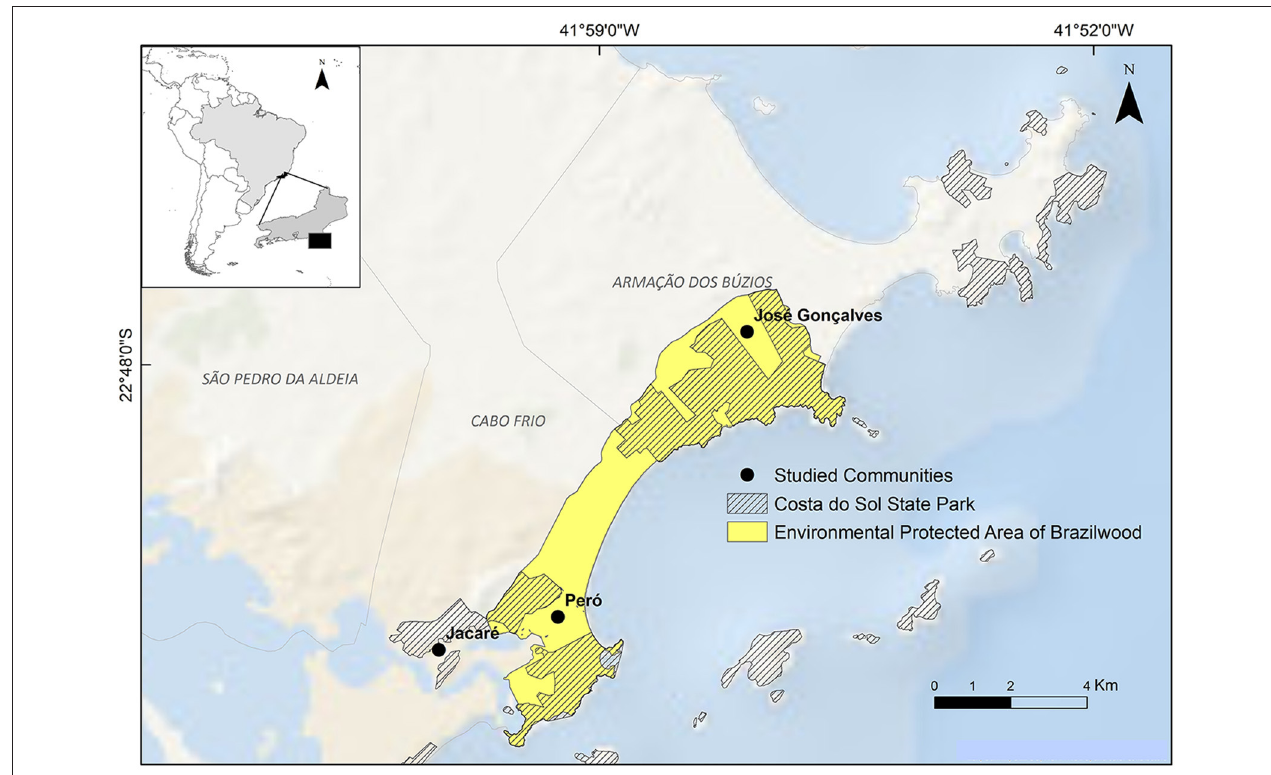
FIGURE 2 | Study area: local communities studied and the local protected areas: PECS (Costa do Sol State Park) hatched and APABR (Pau Brasil Environmental Protected Area) in yellow.